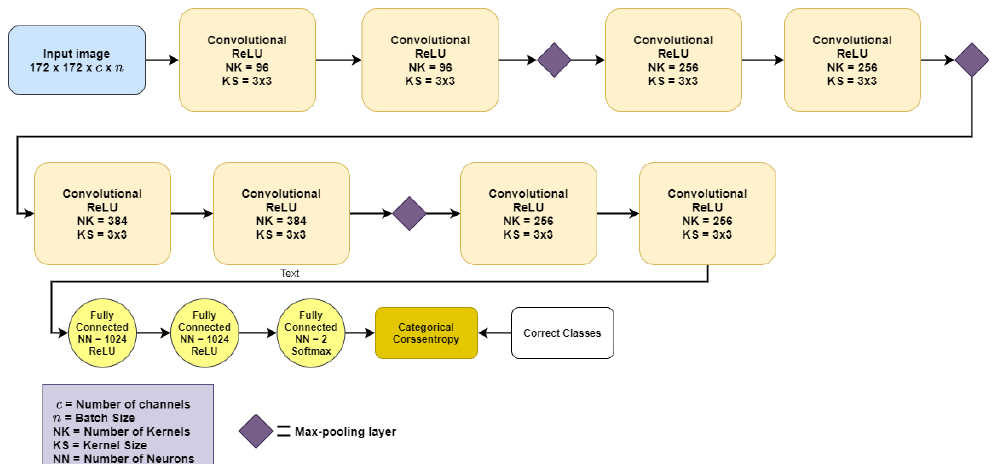
Figure 7. AlexNet CNN model for glaucoma